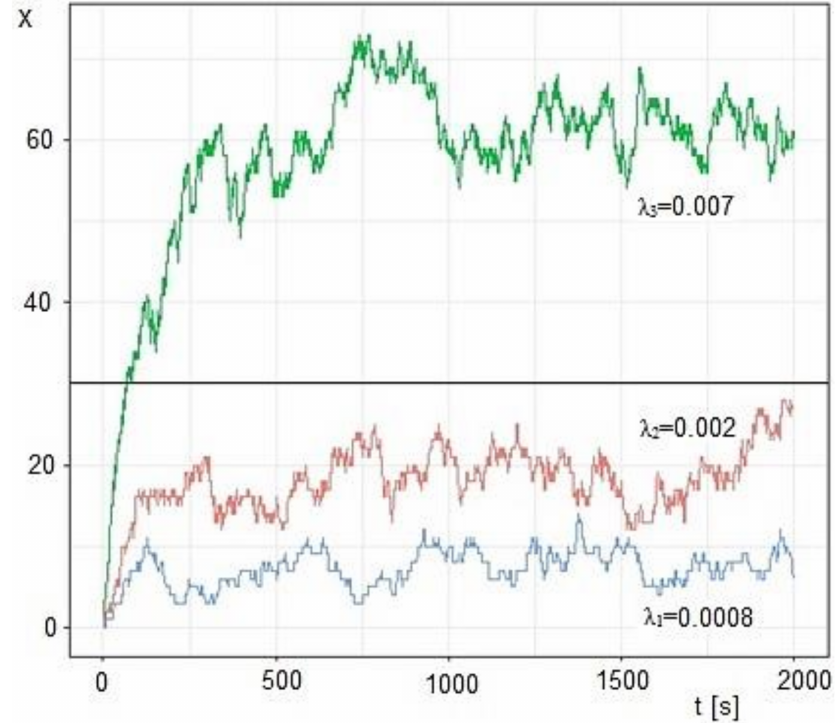
Figure 1. Simulation of transition between states in consecutive moments of time t = 2000 (starting from state 0—no pending reports), for µ = 0.009 and values λ 1 = 0.0008, λ 2 = 0.002, λ 3 = 0.007.